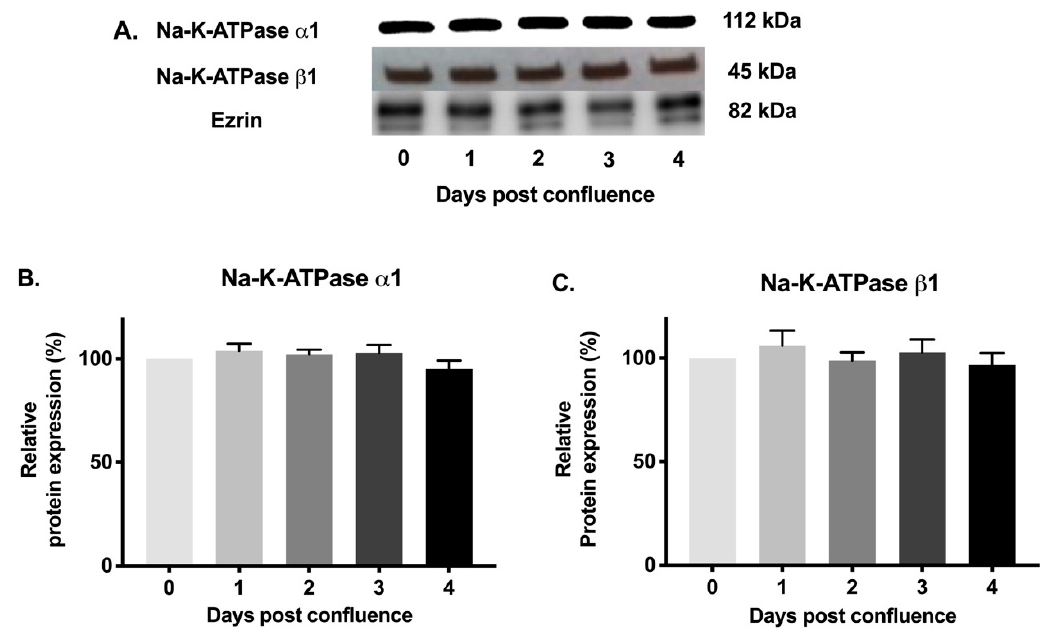
Figure 6. Western blot analysis of IEC-18 cells in cellular homogenates. ( A ). Representative blot of Na-K-ATPase α 1, Na-K-ATPase β 1 and internal control β -actin. Densitometric quantitation of Western blots. ( B ). Na-K-ATPase α 1 and ( C ). Na-K-ATPase β 1. Values are relative to 0-day and normalized to β -actin. Values are represented as mean ± SEM, n = 4.